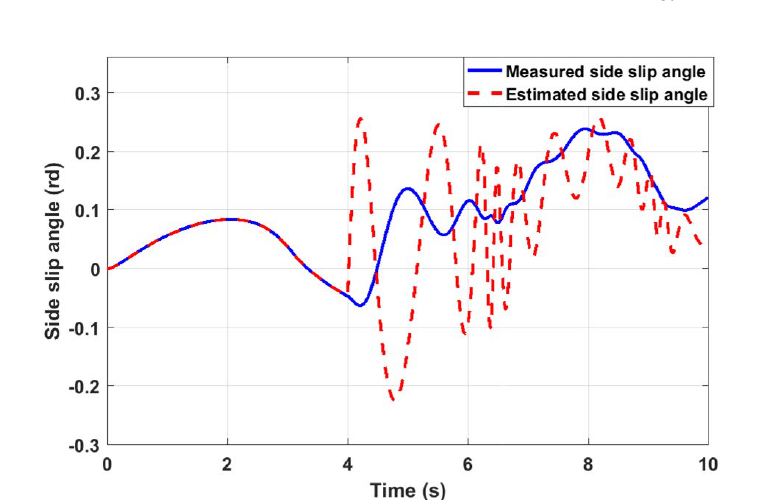
Figure 9. Estimated vehicle sideslip angle without FTC Strategy.